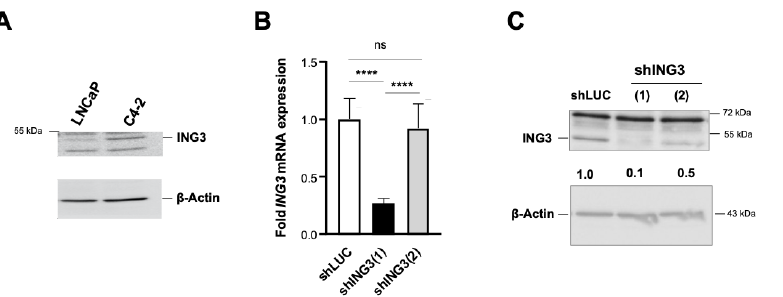
Figure 4. Knockdown of ING3 by retroviral transduction. ( A ) ING3 protein levels were compared between LNCaP and C4-2 cells by Western blotting. Short hairpin vectors were used to knockdown ING3 (shING3). Two vectors with different ING3 targeting sequences were used and transduced into ecotropic C4-2 cells. Seven days post-transduction knockdown, efficacy was analysed at mRNA ( B ) and protein ( C ) levels and compared with empty control vector shLUC, which was set arbitrarily as one. Results represent the mean of triplets, and error bars show standard deviation of the mean. p value < 0.0001 (****); ns: not